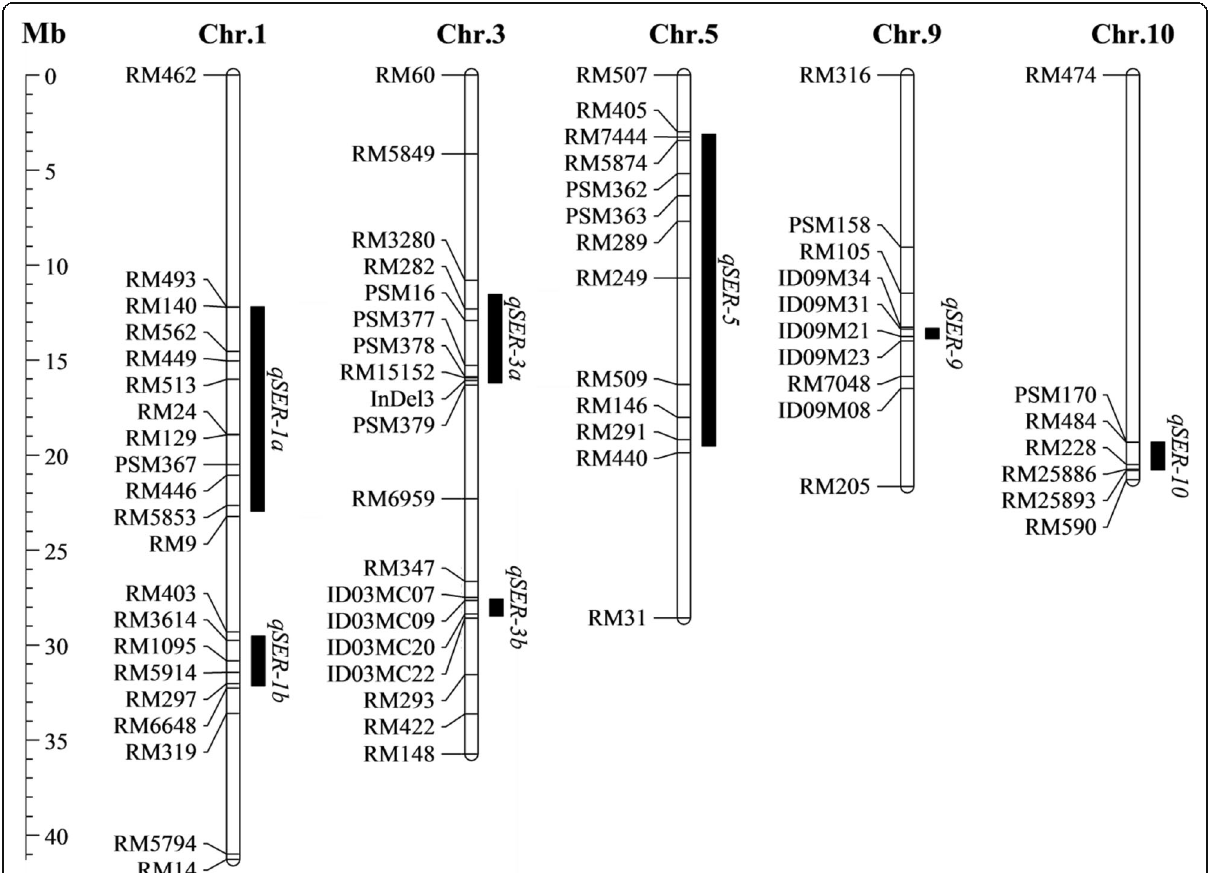
Fig. 5 Chromosomal locations of the seven QTLs for SER in the SSSLs. Black bars on the right of each chromosome are the estimated intervals of QTLs with their names on the right. Chr. chromosome, Mb megabase